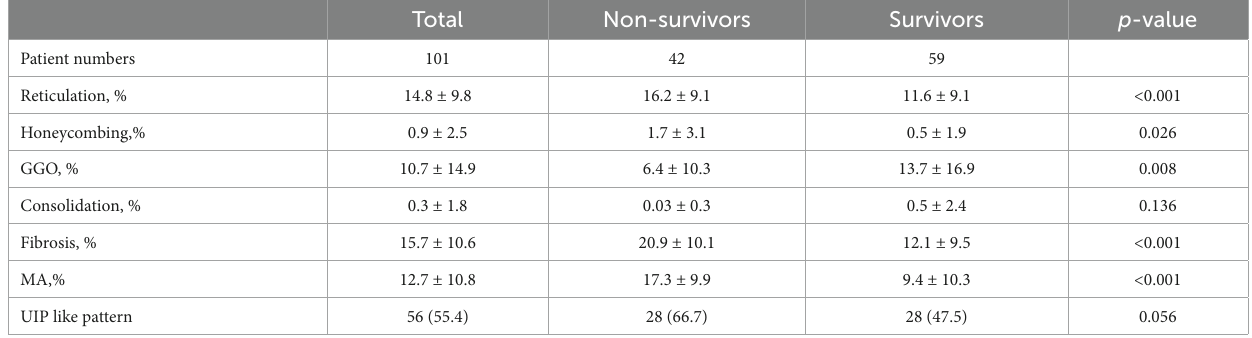
TABLE 2 Comparison of HRCT scores between the non-survivors and survivors patients with fibrotic HP.